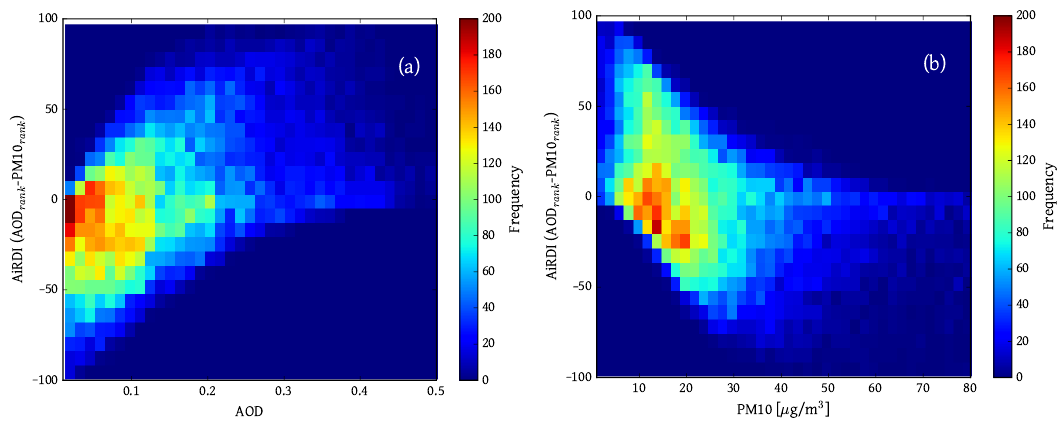
Figure 3. 2D-histograms of AiRDI, AOD rank ( a ) and AiRDI, PM10 rank ( b ). The frequency of occurrence of associated data pairs is